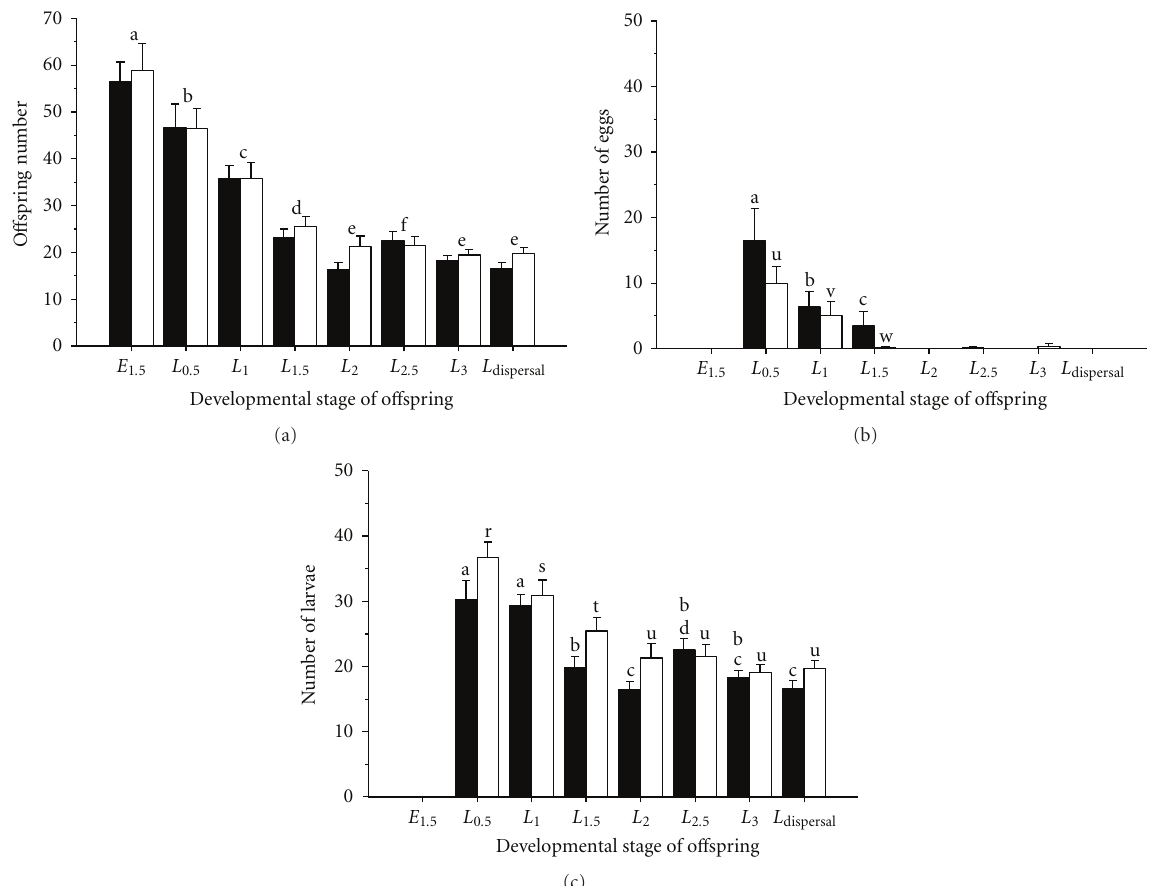
Figure 2: Total number of o ff spring (a), number of eggs present after first larvae had hatched (b), and number of larvae (c) in relation to developmental stage of o ff spring for high-density (black bars) and low-density females (white bars). E 1 . 5 : first laid eggs were 1.5 days old; L L L L L L 0 . 5 , 1 , 1 . 5 , 2 , 2 . 5 , and 3 : oldest larvae were 0.5, 1, 1.5, 2, 2.5, or 3 days old; Di ff erent letters above bars in (a) indicate di ff erence at P < 0 . 05 between developmental stages for both female densities combined, while di ff erent letters above bars in (b) and (c) indicate di ff erence at P < 0 . 05 between developmental stages within each female density treatment. Means and SE are